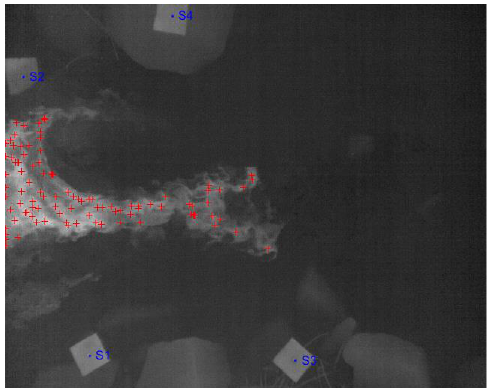
Figure 8. Detected GCPs and tracking features on 61 st image: blue points refer to GCPs while red points represent tracking